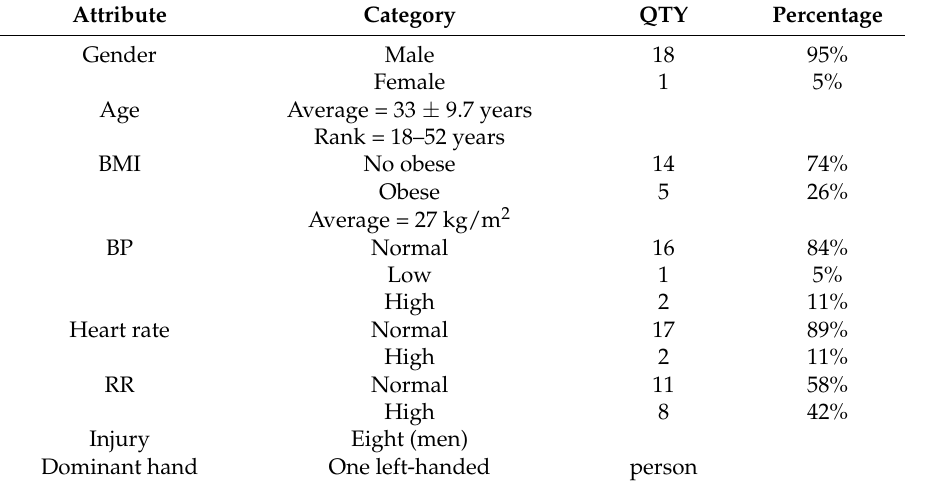
Table 2. Demographic characteristics from the sanding area.